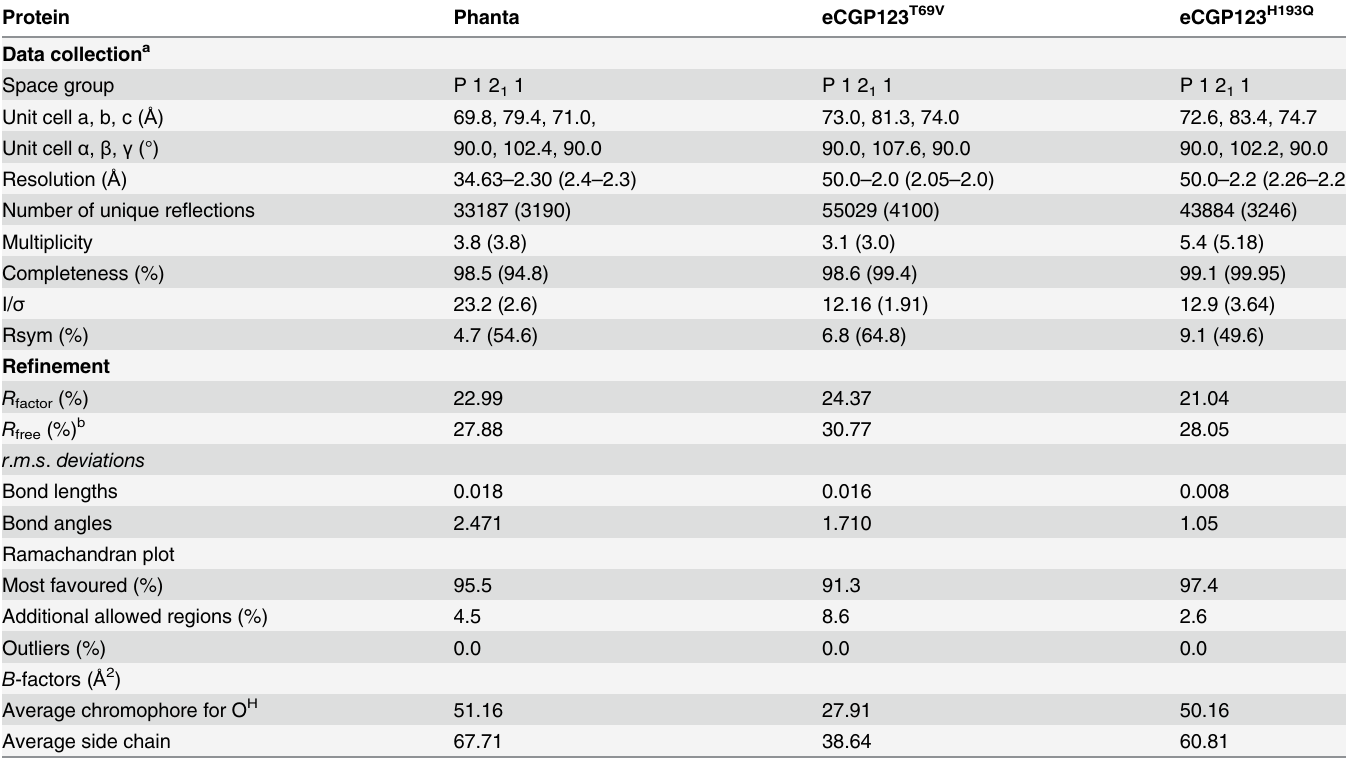
Table 2. Phanta, eCGP123 T69V and eCGP123 H193Q data collection and refinement